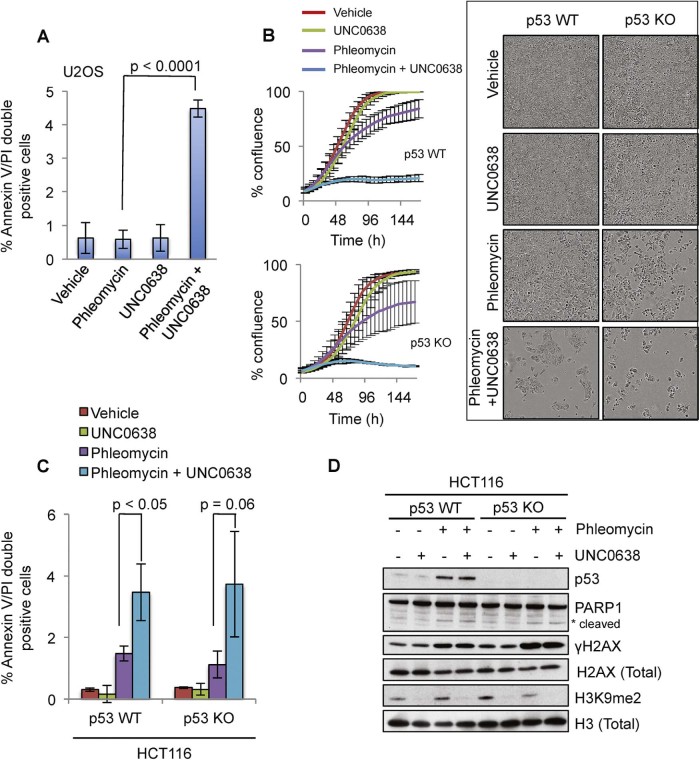
Under low damage condition UNC0638 induces tumour cell death independent of p53 status. (A) U2OS cells were treated as indicated for 4 days and stained with Annexin V and PI for flow cytometry analyses. Combined treatment of UNC0638 (1 µM) and low dose phleomycin (1 µM) significantly increases U2OS cell death as measured by percentage of Annexin V/propidium iodide double-positive cells compared to cells treated with phleomycin alone. Error bars correspond to SDs of three independent experiments. (B) Growth curves for HCT116 p53+/+ (WT) and p53−/− (KO) cells with indicated treatments show that co-treatment of UNC0638 (1 µM) with phleomycin (0.5 µM) inhibits growth of HCT116 cells independent of p53 status. Representative phase-contrast images of cells at the end-point of the confluence assay are shown. (C) HCT116 p53 WT and KO cells were treated with indicated treatments for 4 days and stained with Annexin V and PI for flow cytometry analyses. UNC0638 treatment in the presence of low dose phleomycin increases the cell death (% Annexin V/propidium iodide double-positive cells) for both p53 WT and KO cells compared to phleomycin treatment alone. Statistical analyses were performed as in (A). (D) No increase in PARP1 cleavage was observed upon co-treatment of UNC0638/phleomycin compared to phleomycin treatment only. See also Fig. S4.